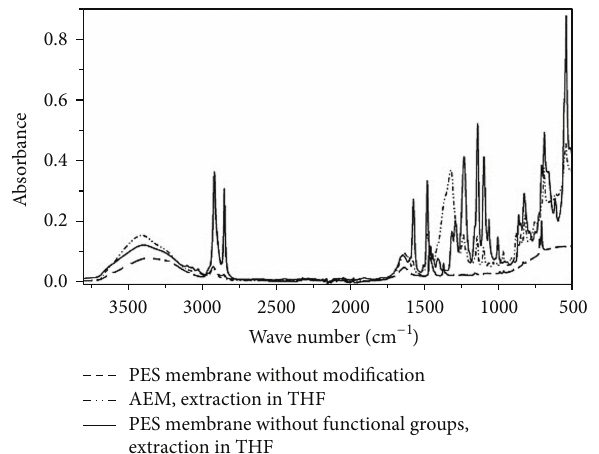
Figure 5: FT-IR spectra of PES membrane without modification, surface modified PES membrane without amino functionalities, and the surface PES AEM, the latter two types of membranes coated with surface layer 2 and treated with THF extraction.